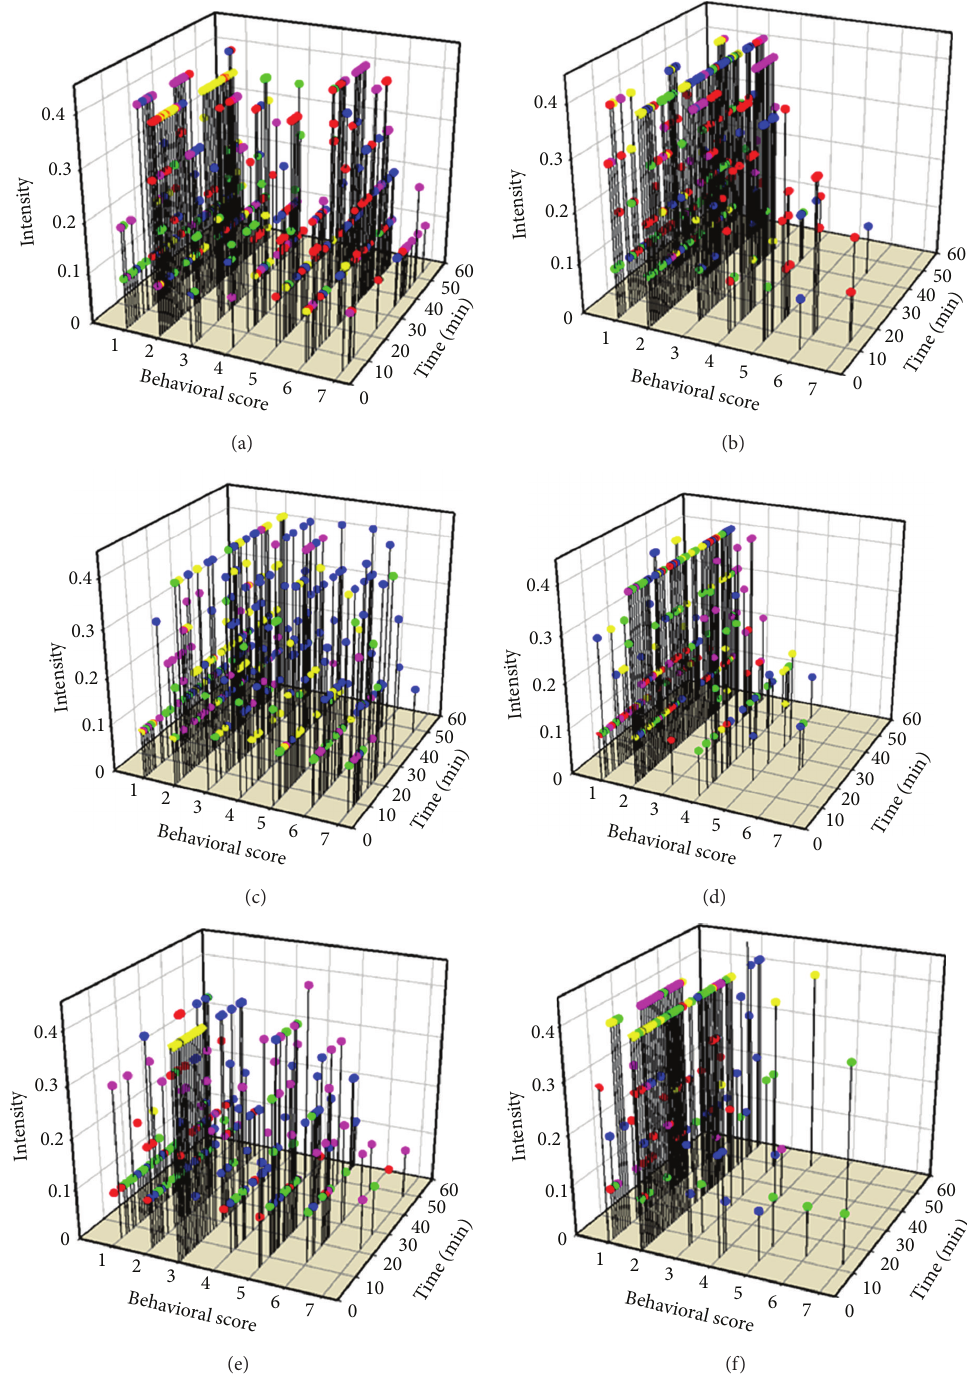
Figure 6: Comprehensive representation of social interactions for sighted crayfish in varying environmental conditions. (a) Red light and in water. (b) Red light and out of water. (c) Low white light, no antennules, and in water. (d) Low white light, no antennules and, out of water. (e) Red light, no antennules and, in water. (f) Red light, no antennules and, out of water. A single vertical line indicates a given behavior at a specific point in time as well as the intensity of the behavior. The different colored points represent individual pairs in the trials (𝑁 = 5)